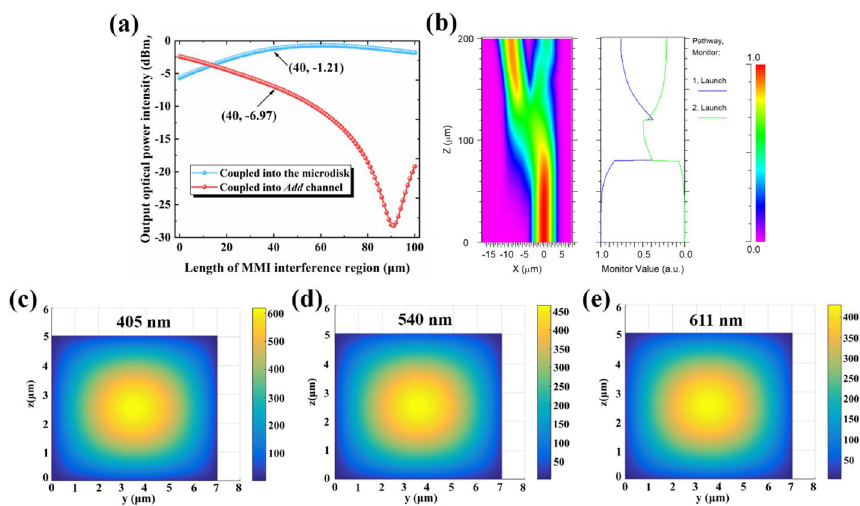
Fig. 3 The design of the MMI power distributor and calculation results of optical field modes in waveguide core layers at different wavelengths. a The output optical power intensity at different interference region lengths; b optical field distribution on the x–y plane; c , d , and e were the cross-sectional optical field distributions of fundamental mode in waveguide core layer at 405, 540, and 611 nm wavelength,